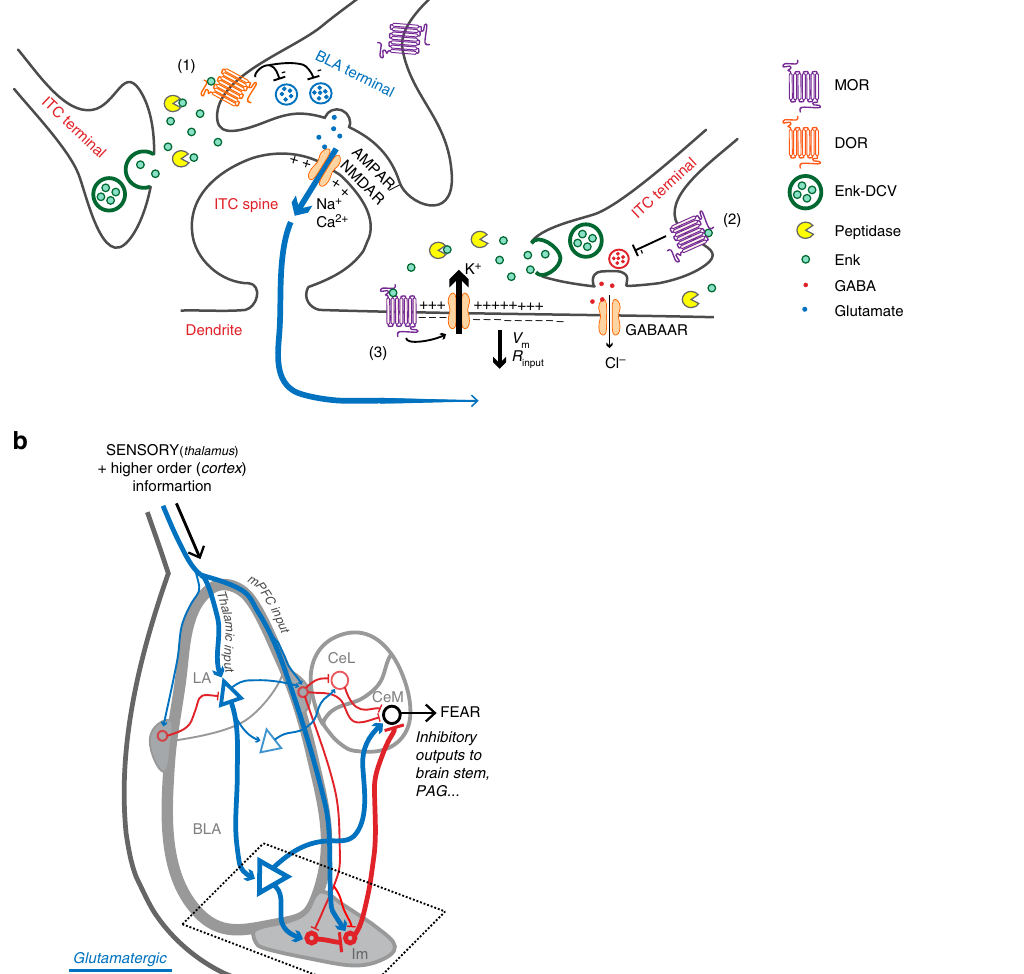
amygdala, this was correlated with increased vulnerability to negative stress responses 59 . While opioid receptors and peptides are expressed and likely act in other subdivisions of the amygdala 21,56,60 , the strong regulation of Im neurons by endogenous opioids is an appealing mechanism for opioid